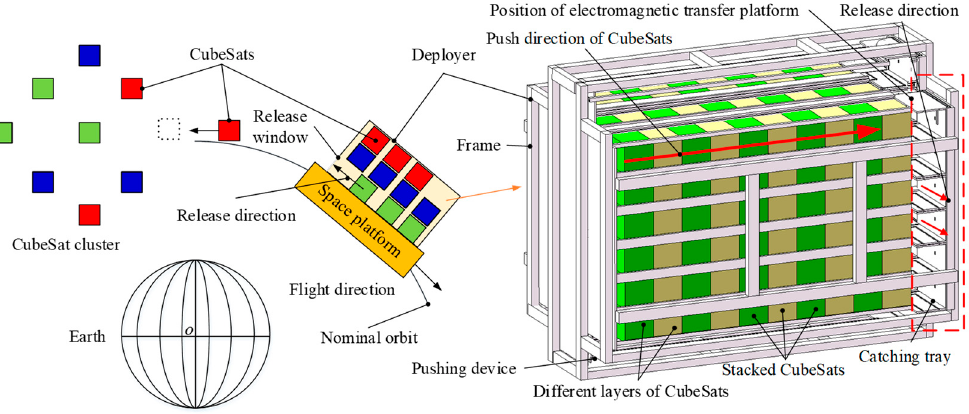
Figure 1. Separation process of the stacked CubeSats in the new deployer.